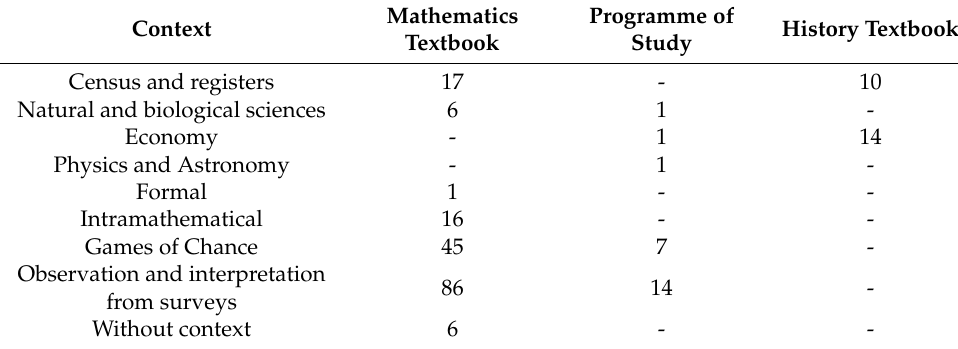
Table 5. Types of contexts mobilised in the 10th grade tasks (Source: Prepared by the authors). Mathematics Programme of Context History Textbook Textbook Study Census and registers 17 -